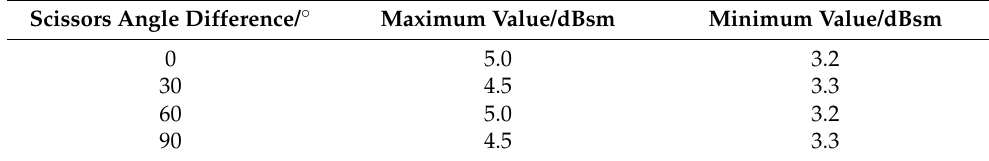
Table 14. Maximum and minimum average RCS values in fixed-wing mode at an azimuth angle = 0 ◦ . Scissors Angle Difference/ ◦